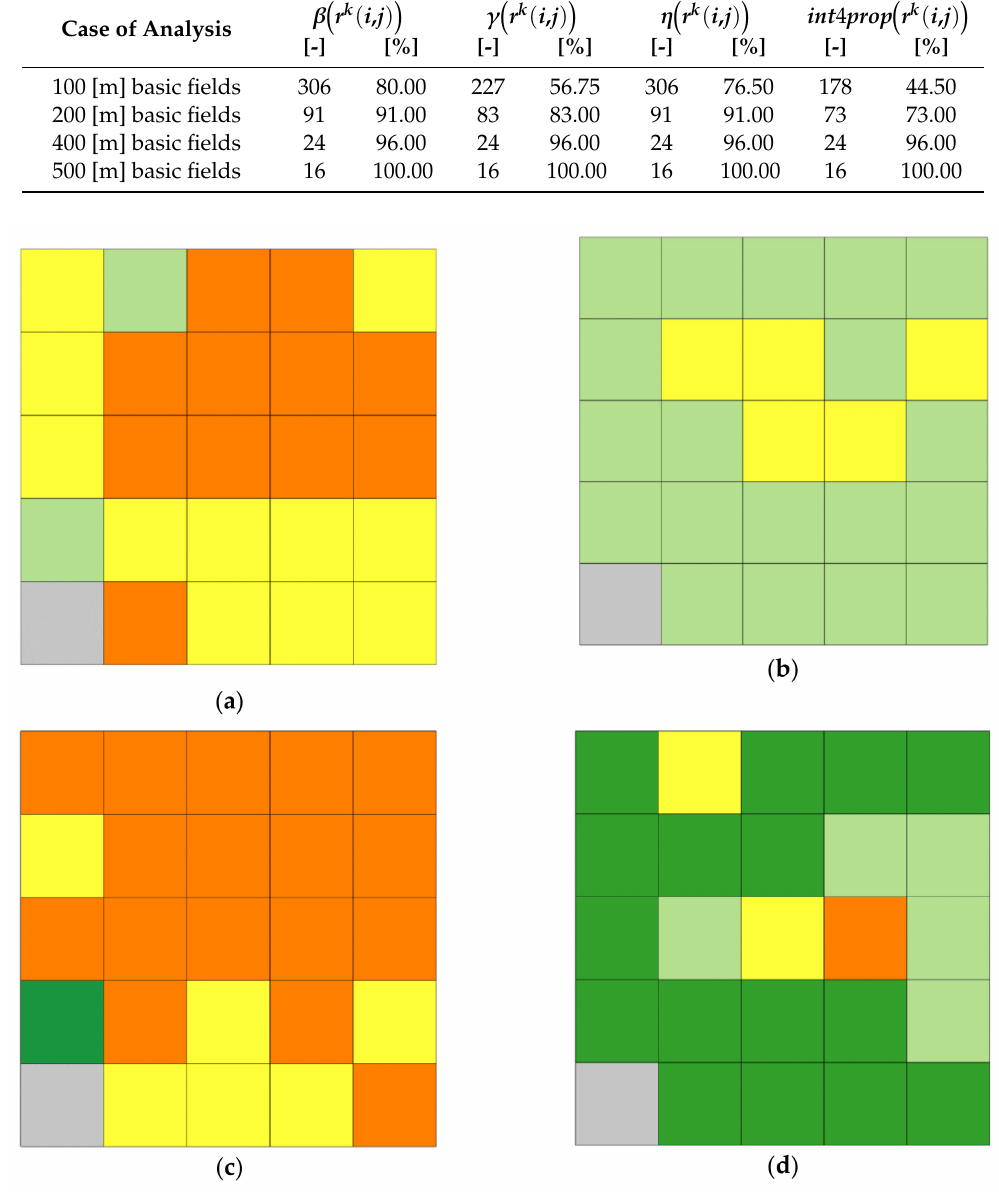
Figure 8. Level of connectivity for each basic field for k = 3 (400 m basic fields): ( a ) beta measure; ( b ) gamma measure; ( c ) eta measure; ( d ) four-way intersection